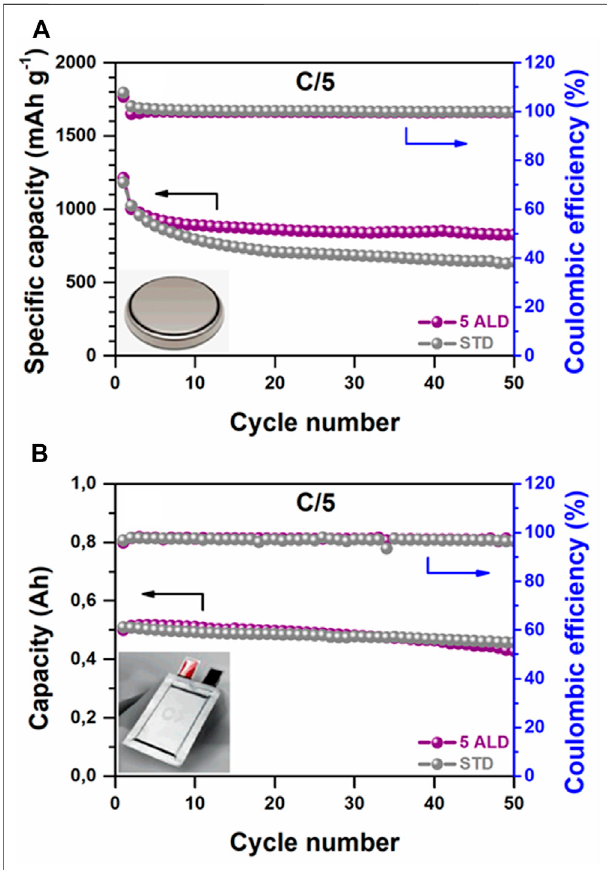
FIGURE 2 | Electrochemical performance of rechargeable standard (STD) and FBR-ALD coated (5 ALD) sulfur cathodes in Li-S batteries was measured at 25 ° C. Galvanostatic long cycling performance at C/10 in (A) coin cell and (B) pouch cell format.